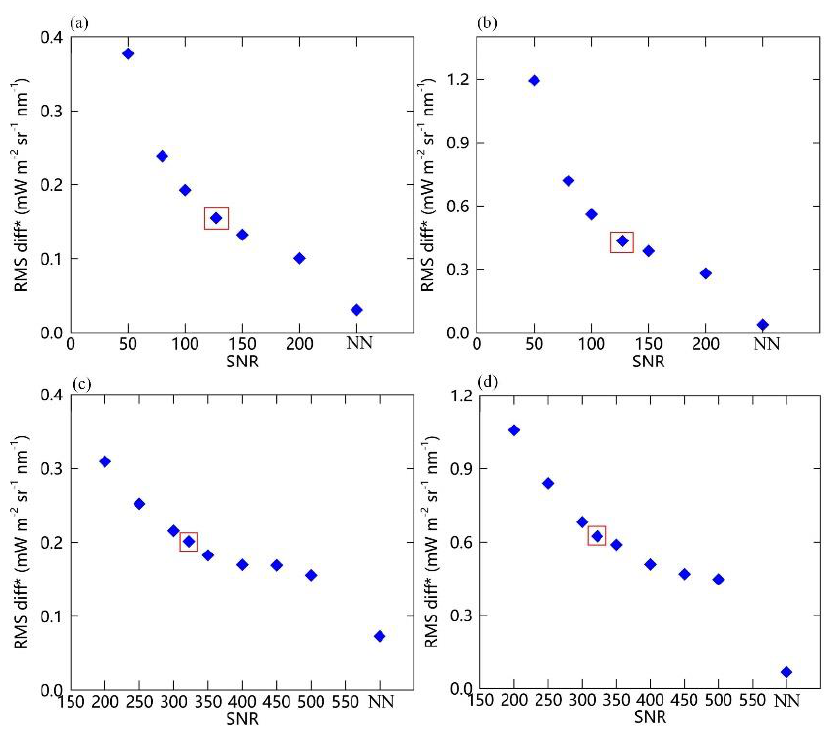
Figure 11. Variations of RMS diff* of SIF retrievals at far-red ( a ) and red ( b ) bands using simulations with a different SNR and SR of 0.1 nm ( a , b ) and 0.3 nm ( c , d ). ‘NN’ indicates the noise-free simulations condition. The red box refers to the RMS value of the simulations with SNRs of 127 ( a , b ) and 322 ( c , d ), respectively.